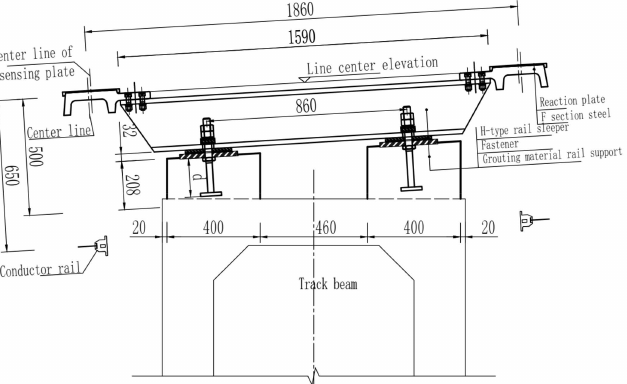
Figure 2. Cross section diagram of track beam structure in curved section of maglev commercial operation line.